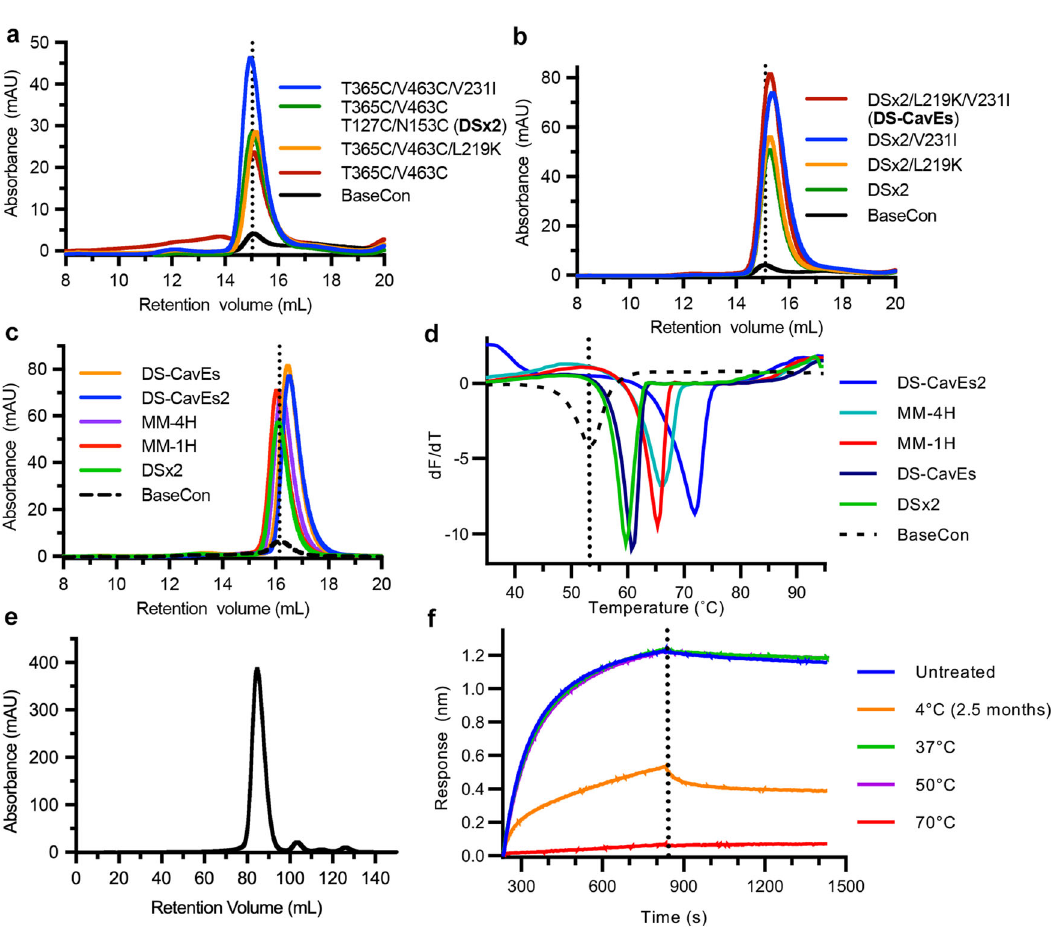
Fig. 3 Characterization of multiple-substitution hMPV F variants. a – c SEC of puri fi ed multiple-substitution hMPV F variants. A vertical dotted line indicates the peak retention volume for the hMPV F base construct. d DSF analysis of thermostability of multiple-substitution F variants. The vertical dotted line indicates the melting temperature for the base construct. e SEC trace of DS-CavEs2 puri fi ed from a 1 L culture of FreeStyle 293-F cells. f Binding of heat-treated DS-CavEs2 or DS-CavEs2 stored for 2.5 months at 4 °C to MPE8 Fab measured by biolayer interferometry. A vertical dotted line indicates the end of the association step. Untreated DS-CavEs2 was included as a control. Source data are provided as a Source Data fi le for panels a – f